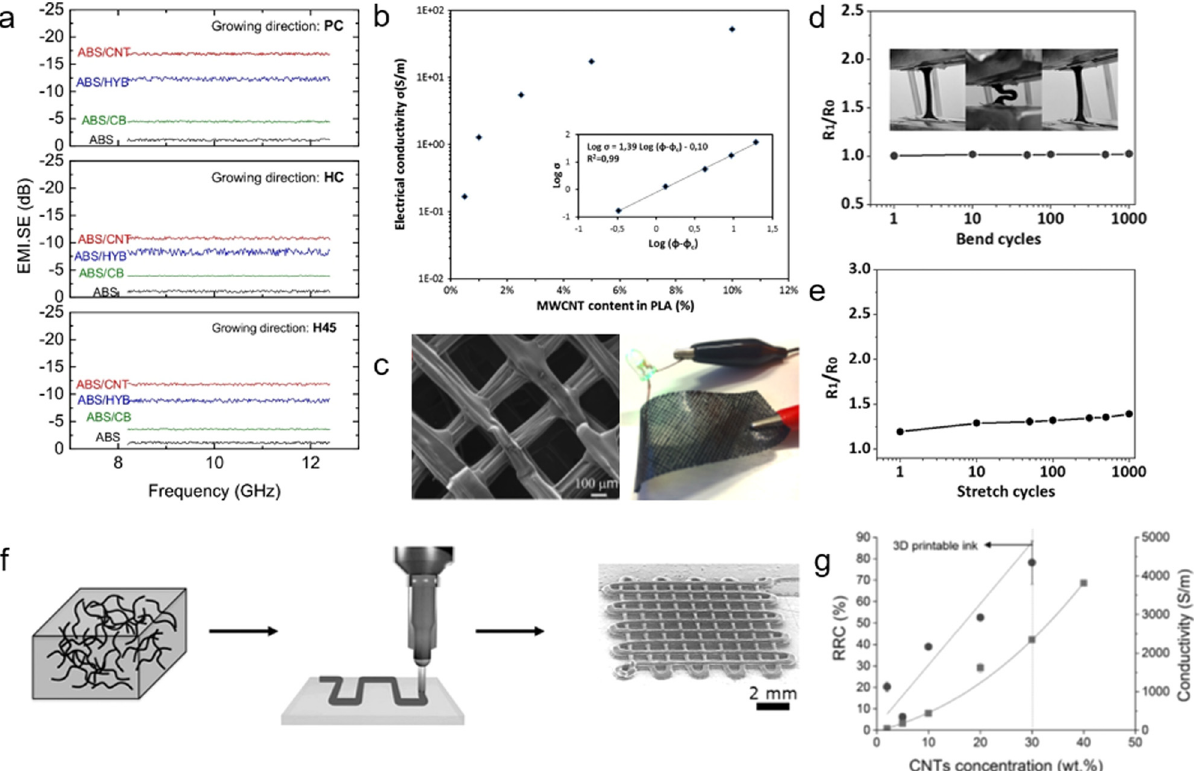
Figure 4: ( a ) Total electromagnetic interference shielding e ff ectiveness of ABS carbon - based composites in three di ff erent layer - by - layer growing directions: perpendicular ( upper graph ) , horizontal concentric ( middle graph ) , and horizontal alternate ( bottom graph ) . Reproduced with permission from ref. [ 69 ] , Copyright 2018 Elsevier. ( b ) Volume electrical conductivity as a function of MWCNT concentra - tion. The inset shows the log – log plot of the electrical conductivity versus the volume fraction of MWCNTs. ( c ) SEM images of 3D printed MWCNT - based nanocomposite woven structure and used as conductive element in a simple electrical circuit. Reproduced with permission from ref. [ 70 ] , Copyright 2015 Elsevier. ( d ) The electrical resistance variation with the bending cycles. The inset shows the bending process. ( e ) The electrical resistance variation for the composites at a maximum strain of 10% with the stretching cycles. Reproduced with permis - of 3D printing method used for fabrication of CNT/PLA sca ff old structures, and SEM image of a sca ff old printed in two layers using the 3D printing method. ( g ) Liquid sensitivity of CNT/PLA sca ff olds ( circle ) and electrical conductivity ( square ) of bulk CNT/PLA composites as a function of CNTs concentration. Reproduced with permission from ref. [ 75 ] , Copyright 2016 Wiley -